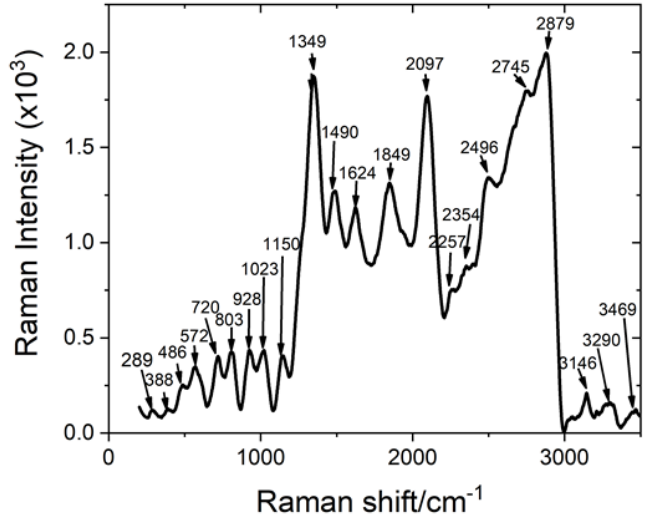
Figure 7. The Raman peak of brewed tea without deltamethrin pesticides.